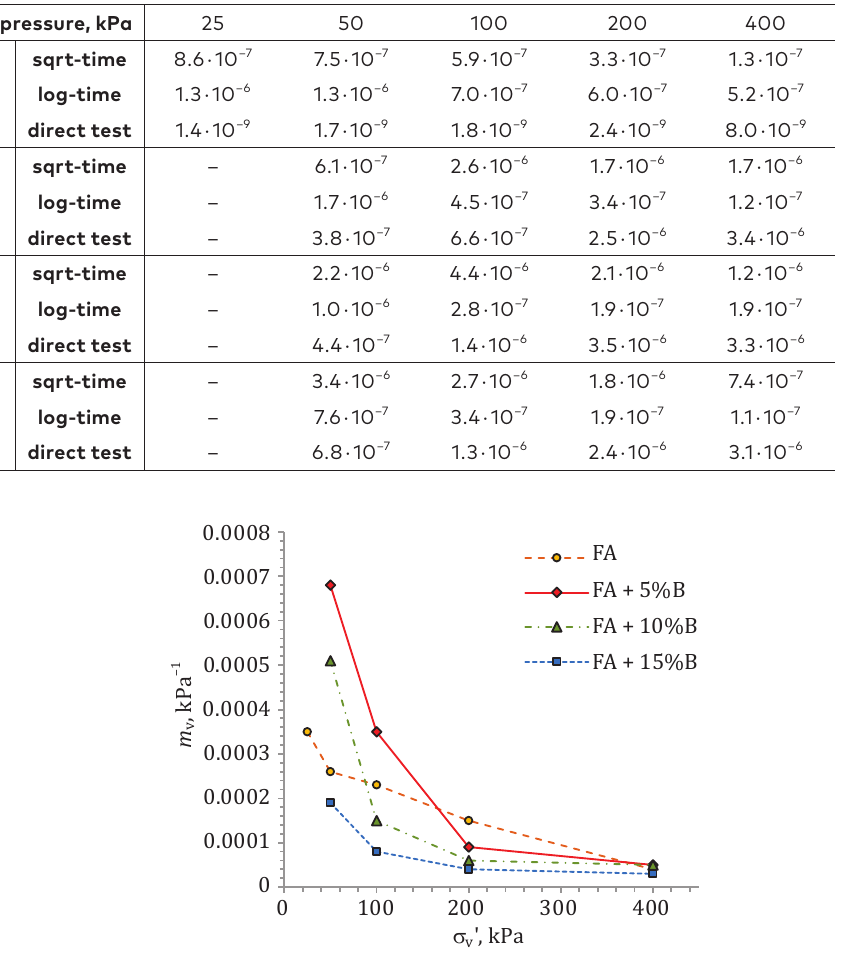
Figure 9. Variation of coefficient of volume change m v versus effective stress σ v ’ for fly ash and fly ash-bentonite